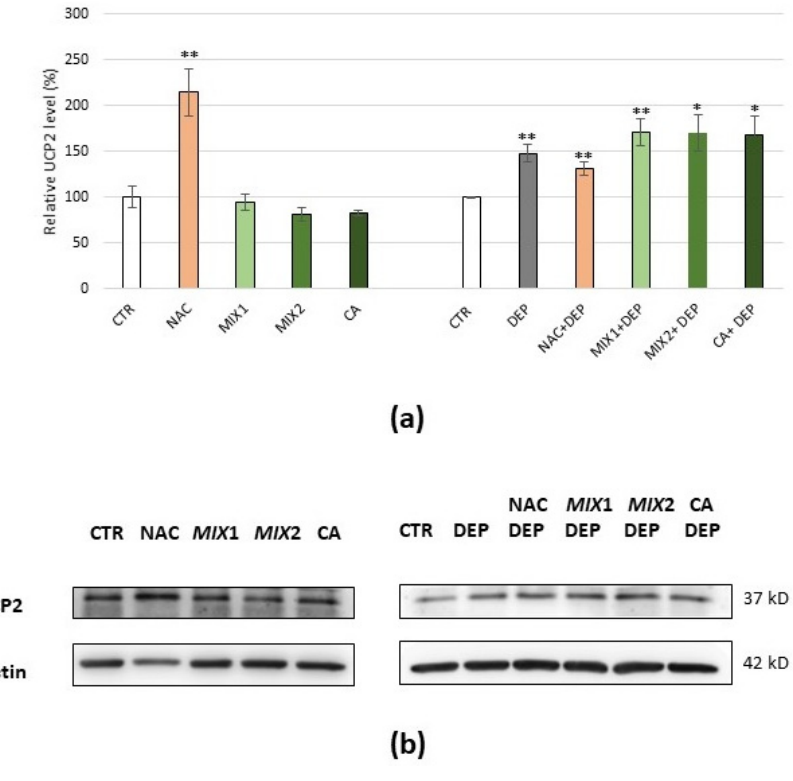
Figure 9. Immunoblotting analysis of UCP2. ( a ) Protein was evaluated following cell treatment carried out only with antioxidants (5 mM NAC for 24 h, 0.5 µ M Mix 1 or 1 µ M Mix 2 or 1 µ M caffeic acid (CA) for 48 h), only with pro-oxidant (25 µ g/mL DEPs for 12 h), and finally with the different antioxidants and subsequent exposure to DEPs. Protein was normalized for the corresponding β -actin signal in each lane and expressed as a percentage of the control. Values represent mean ± SE obtained from three independent experiments. * p < 0.05 versus control, ** p < 0.01 versus control. ( b ) Corresponding representative immunoblotting images.